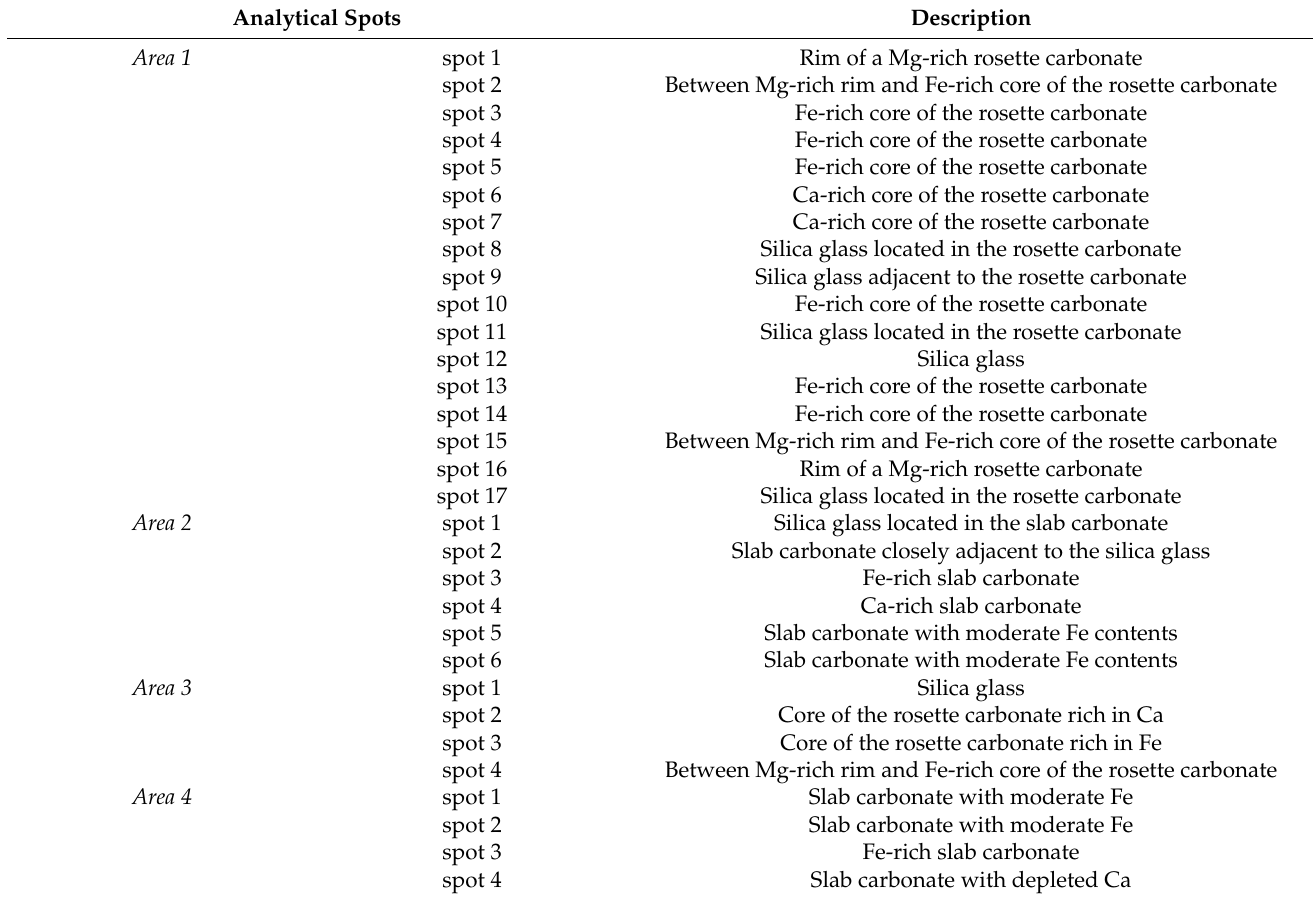
Figure 2. Backscattered electron (BSE) and synchrotron XRF mapping (Fe = red; Ca = blue) images. ( A – C ) Area 1, ( D ) Area 2, ( E ) Area 3, and ( F ) Area 4. The white crosses shown in the XRF mapping denote the µ -extended X-ray absorption fine structure (EXAFS) analytical spots. Table 1. Description on the µ -EXAFS analytical